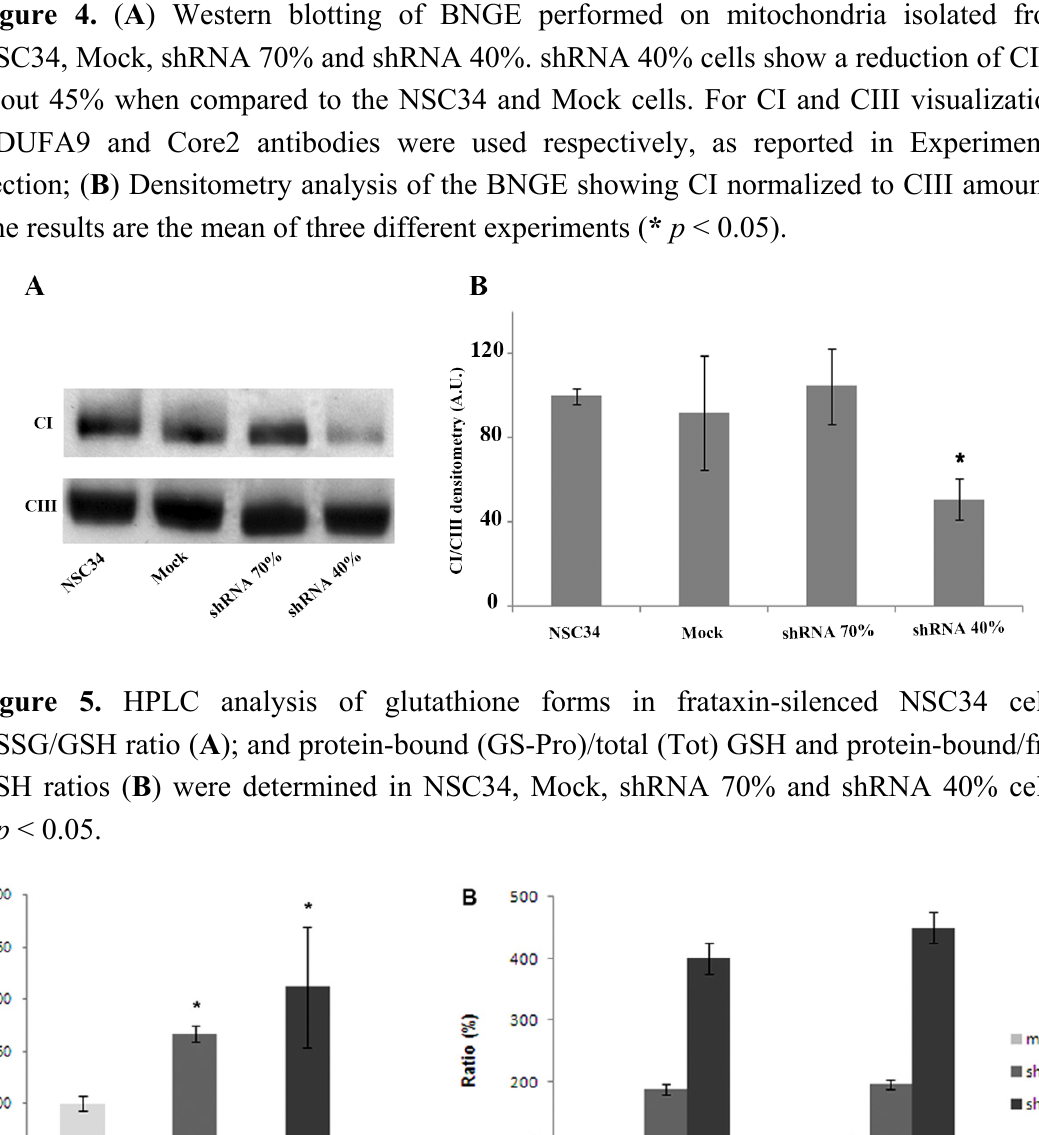
Figure 4. ( A ) Western blotting of BNGE performed on mitochondria isolated from